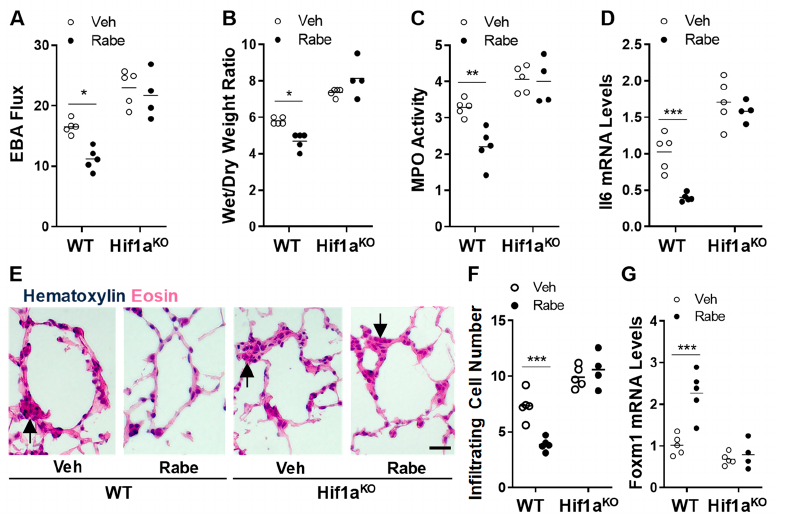
Figure 6. Rabeprazole enhances vascular repair and resolution of sepsis-induced inflammatory lung injury through HIF-1 α . WT or Hif1a/Tie2 Cre knockout (Hif1a KO ) mice received LPS (2.5 mg/kg, i.p.). At 4 and 20 h post-LPS, mice were treated with PBS vehicle or Rabeprazole (18 mg/kg, oral). Lungs were analyzed at 52 h post-LPS. ( A ) EBA flux assay demonstrating that Rabeprazole treatment-in- duced decreases in vascular permeability seen in WT mice were absent in conditional Hif1a/Tie2Cre KO mice. ( B ) Rabeprazole-induced reduction in lung edema measured by lung wet/dry weight ratio was dependent upon HIF-1 α . ( C ) MPO activity assay showing that Rabeprazole reduces neutrophil sequestration in lungs of WT but not Hif1a/Tie2Cre KO mice. ( D ) Pulmonary expression of proin- flammatory cytokine Il6 was reduced by Rabeprazole treatment in WT but not Hif1a/Tie2Cre mice. ( E ) Representative images of infiltrating peri-vascular cells in H&E-stained lungs from Rabeprazole- treated and Rabeprazole-free WT and Hif1a/Tie2Cre mice at 52 h post-LPS. Arrows indicate infil- trated peri-vascular cells. Scale bar = 50 μ m. ( F ) Quantifications of infiltrated proinflammatory cells per vessel <150 μ m. ( G ) Pulmonary FoxM1 expression was increased by Rabeprazole treatment in an HIF-1 α -dependent manner. * p < 0.05, ** p < 0.01, and *** p < 0.001. Two-way ANOVA with Sidak’s post-tests .